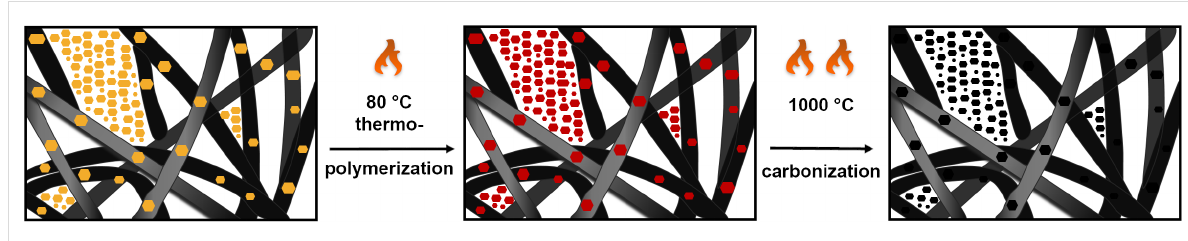
Figure 1: Schematic illustration of the synthesis route using the soft-templating approach to obtain porous carbon–carbon composite electrodes. The colours represent the changes of the appearance of the materials during the synthesis.